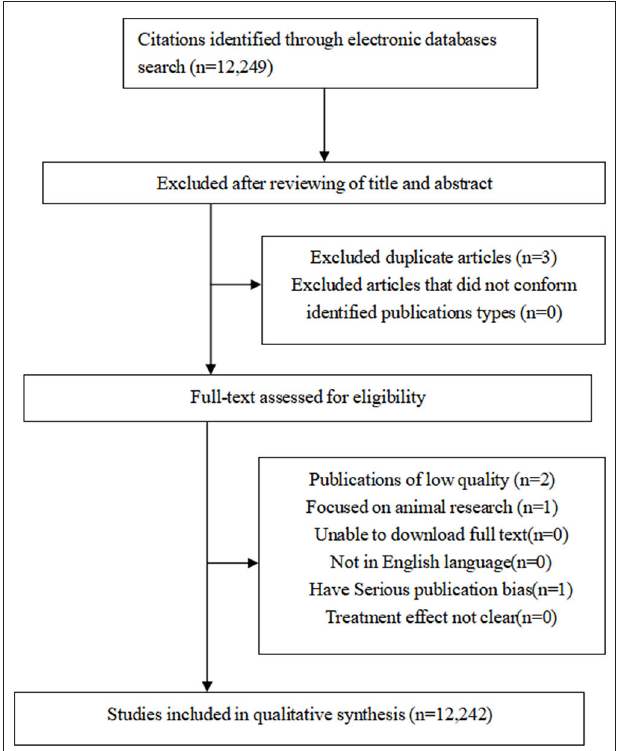
FIGURE 1 | Flow chart of selection processes for eligible